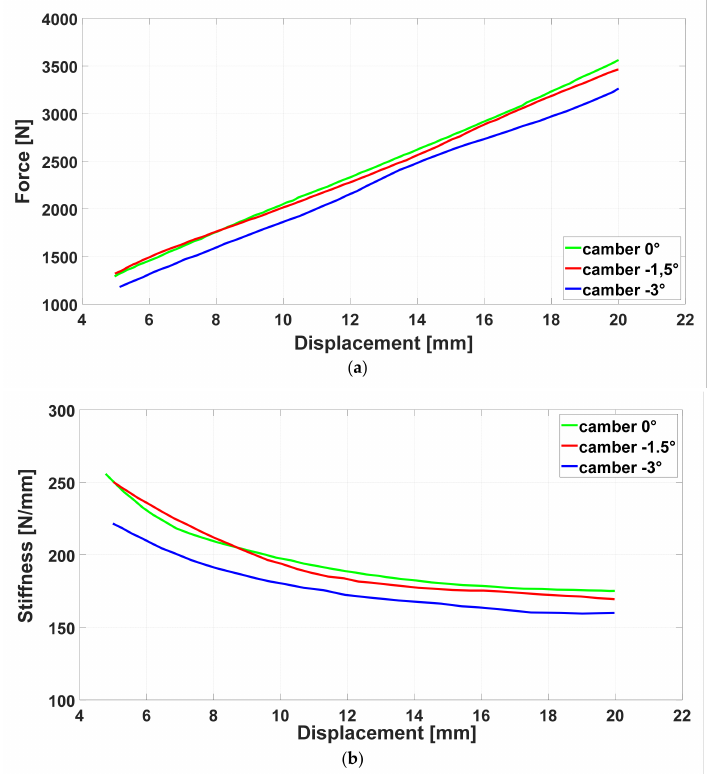
Figure 5. ( a ) Force vs. Displacement experimental diagram; ( b ) Radial Stiffness vs. Displacement experimental